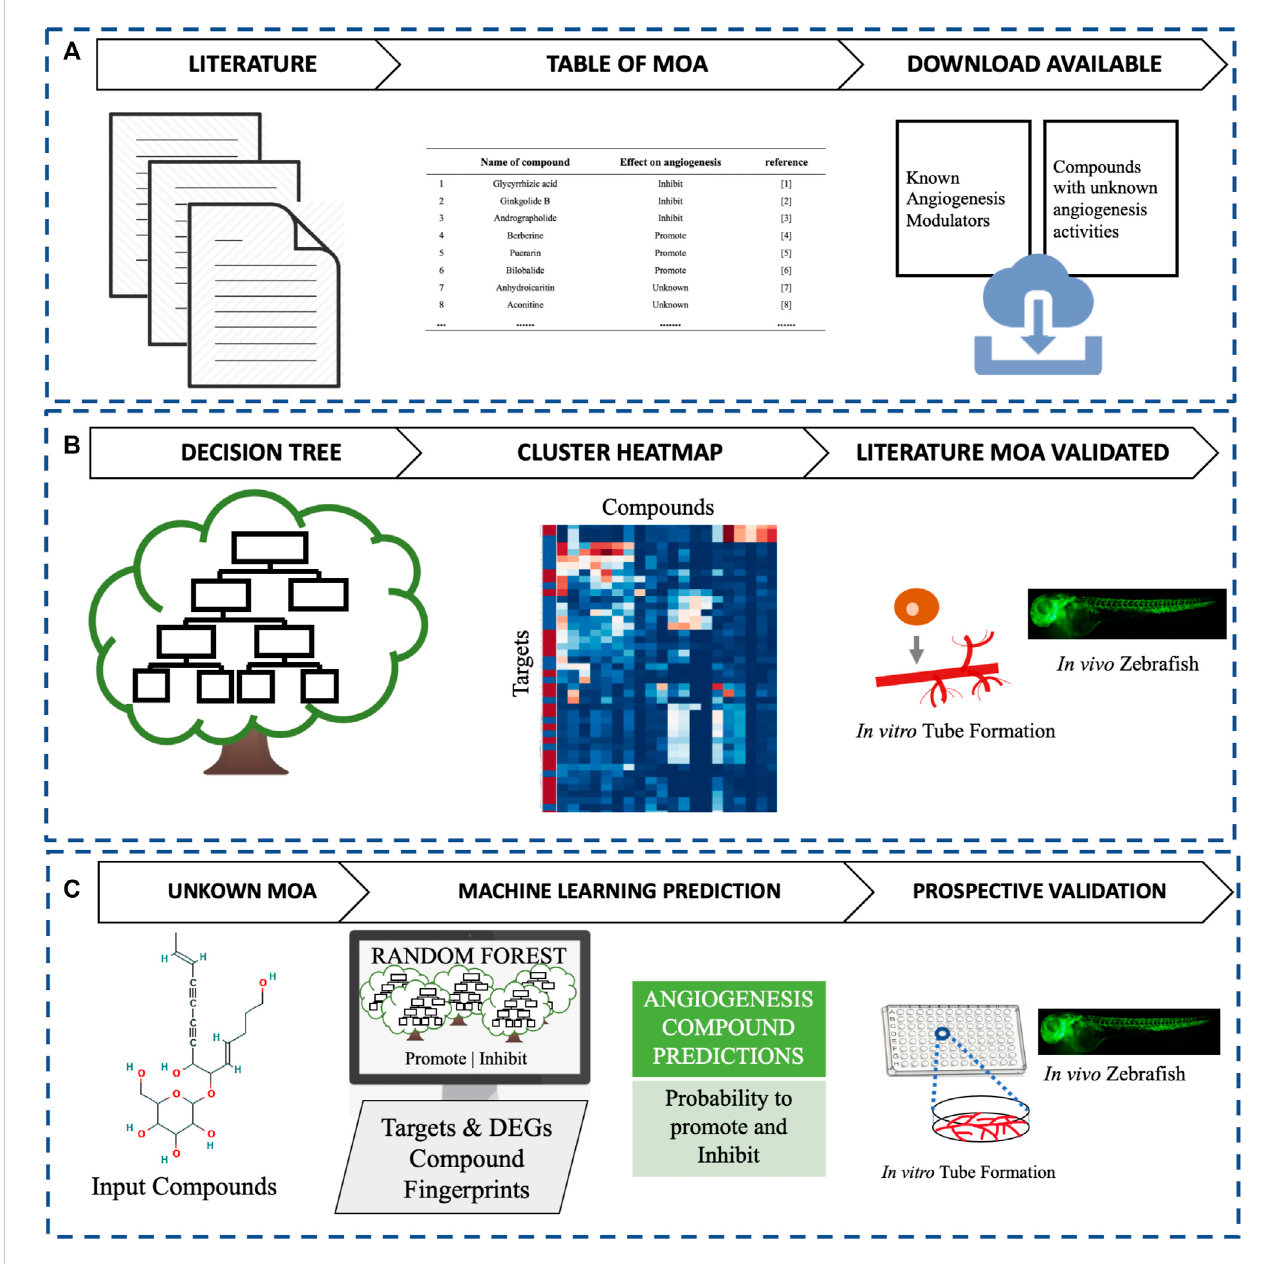
FIGURE 1 This study compromises three main parts. (A) Literature assessment of angiogenesis-modulating individual metabolites from TCM, (B) Decision tree and clustering analysis to validate known mechanisms, and (C) Identi fi cation and assessment of new small-molecule modulators of angiogenesis in vitro and in vivo